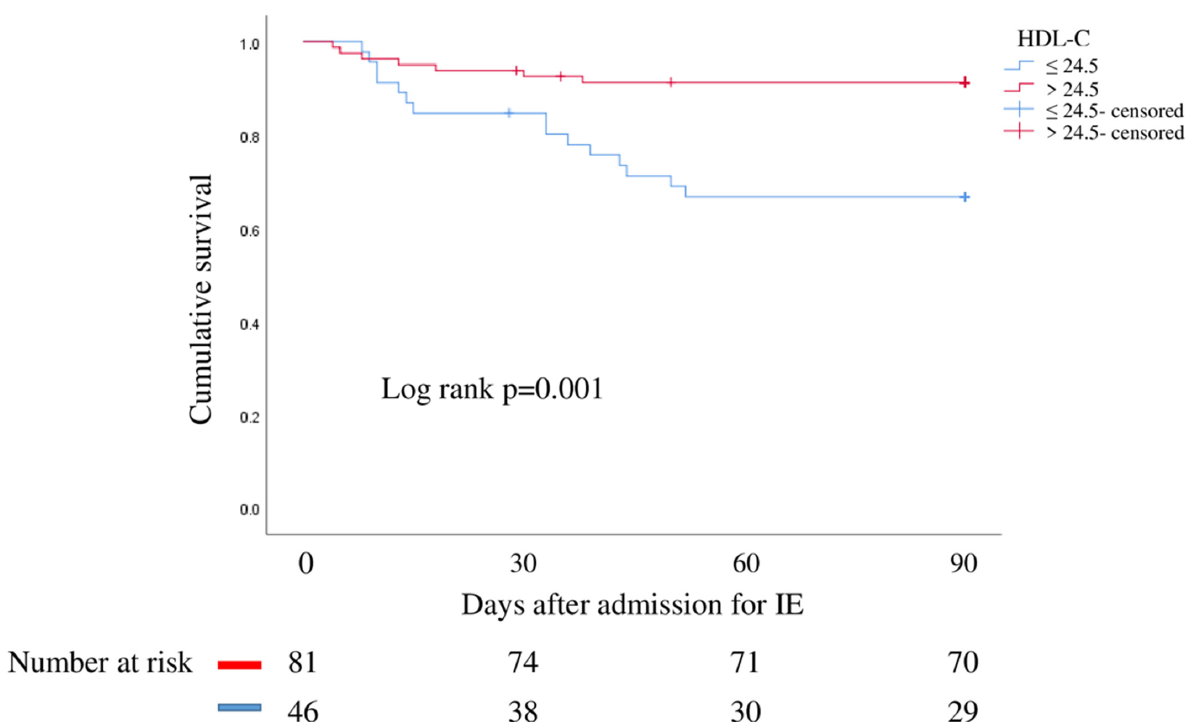
Figure 3. Kaplan–Meier survival analysis at 90 days after hospital admission for IE. Red line indicates patients with HDL-C ≤ 24.5 mg/dL. Blue line denotes patients with HDL-C > 24.5 mg/dL.